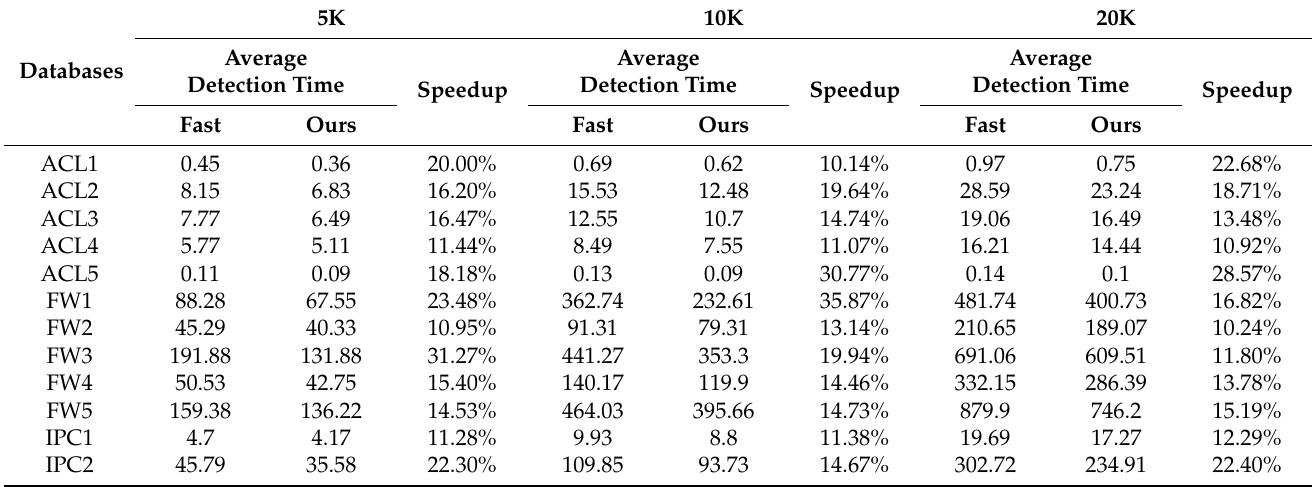
Table 12. Average detection time required to detect conflicts for databases of three sizes.